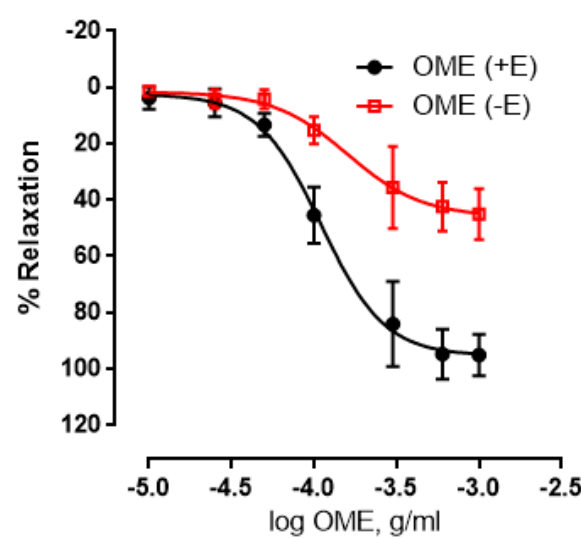
Figure 2. Role of endothelium in OME-induced relaxation. Cumulative dose-response curves for OME in isolated norepinephrine (NE)-pre-contracted rat aortic rings either with intact (+E; black) or denuded endothelium (-E; red). Data are expressed as mean ± SEM ( n = 7; p < 0.01 for +E vs. –E).